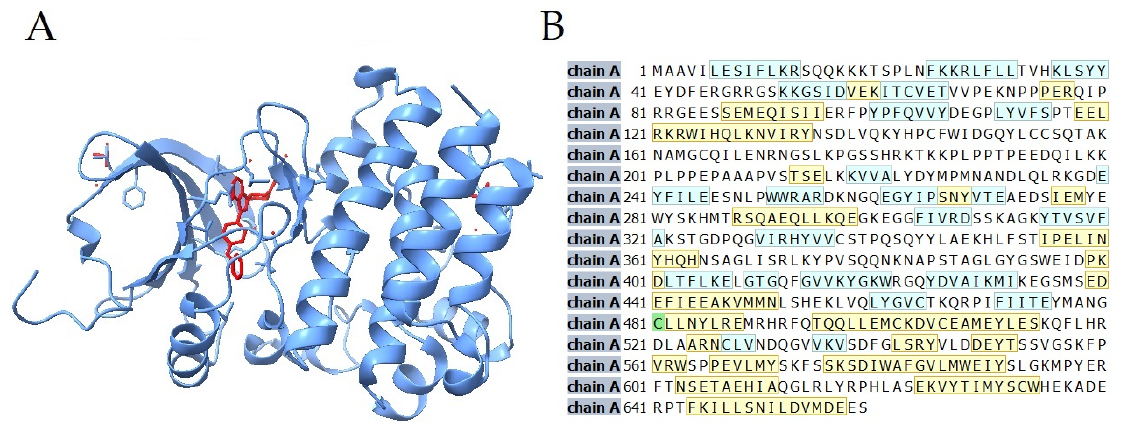
Figure 2. ( A ) Molecular structure of ibrutinib binding Bruton’s Tyrosine Kinase. Shown in color red is ibrutinib; blue represents the kinase [51–53]; ( B ) Sequence of Bruton’s Tyrosine Kinase. BTK is a 659 amino-acid protein. Ibrutinib inhibits BTK by irreversibly binding to cysteine-481, which is marked with the color green. Structure strands are marked with the color blue; structure helices are marked with the color yellow [54–56].